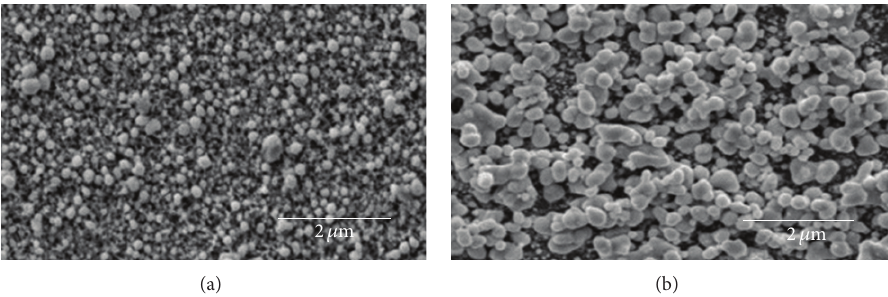
Figure 4: SEM image of (a) RGO-TiO 2 and (b) Ce-RGO-TiO 2 coated ITO substrate.